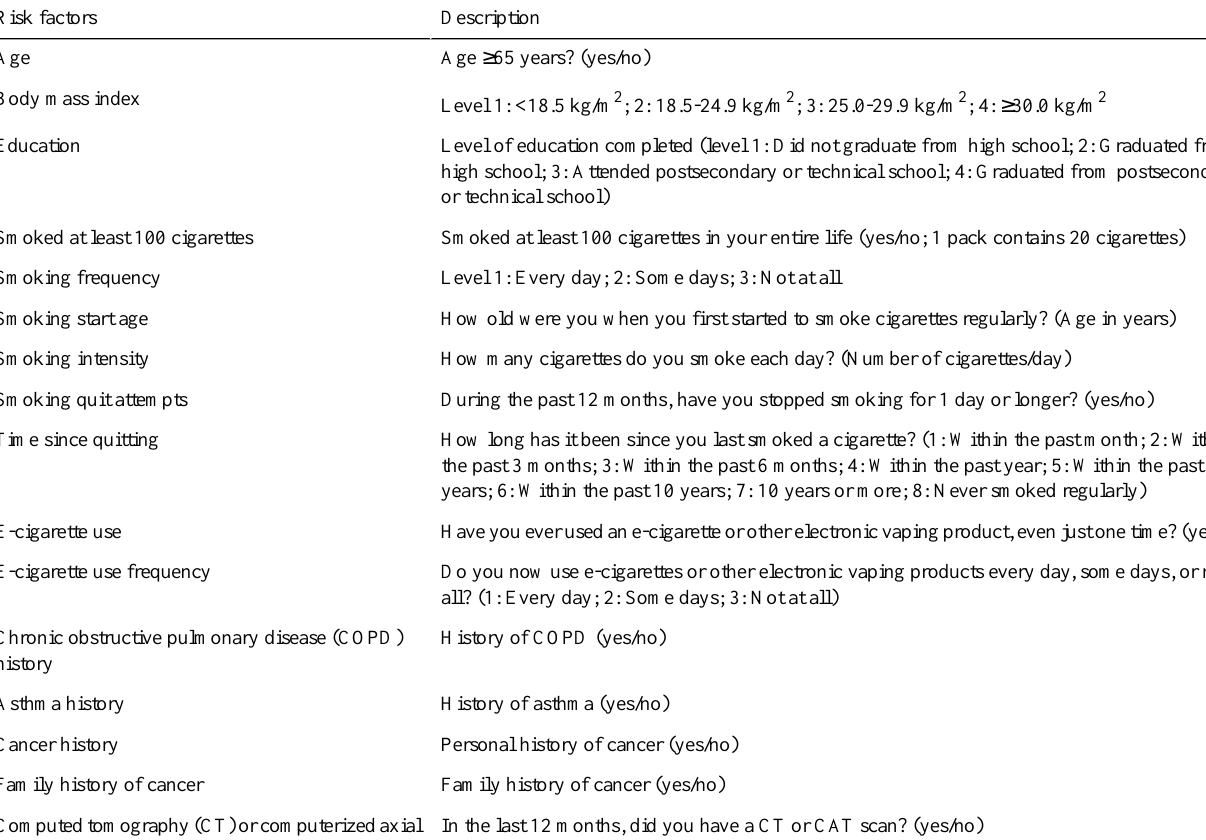
Lung cancer has many causative factors, including age 65 years axial tomography (CAT) scan, asthma history, and COPD and older, body mass index, education, smoking habit, personal history. Table 1 lists some relevant survey questions from the history of cancer, family history of cancer, CT or computerized Table 1. Lung cancer risk factors assessed by the Behavioral Risk Factor Surveillance System